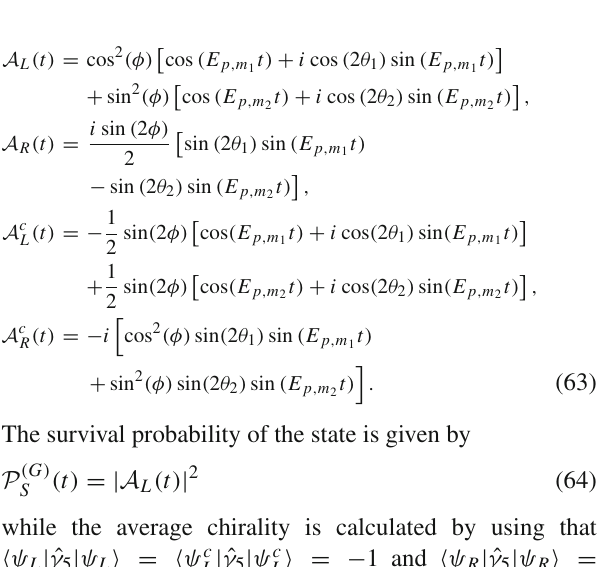
( t ) | ˆ γ | ψ ( M ) ( t ) (cid:2) , thus chiral (cid:6) (cid:6) (cid:30) (cid:30) 5 L L (cid:6) (cid:6) ( t ) ( t ) (cid:6) ψ ( M ) (cid:6) ψ ( D ) and are L L